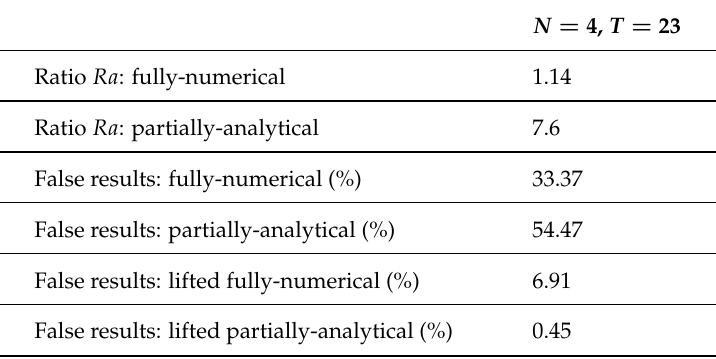
Table 8. UWB self-calibration optimization results with synthetic measurements based on the same geometric constellation as the real 2D measurements. The identified false optimizations have an error larger than